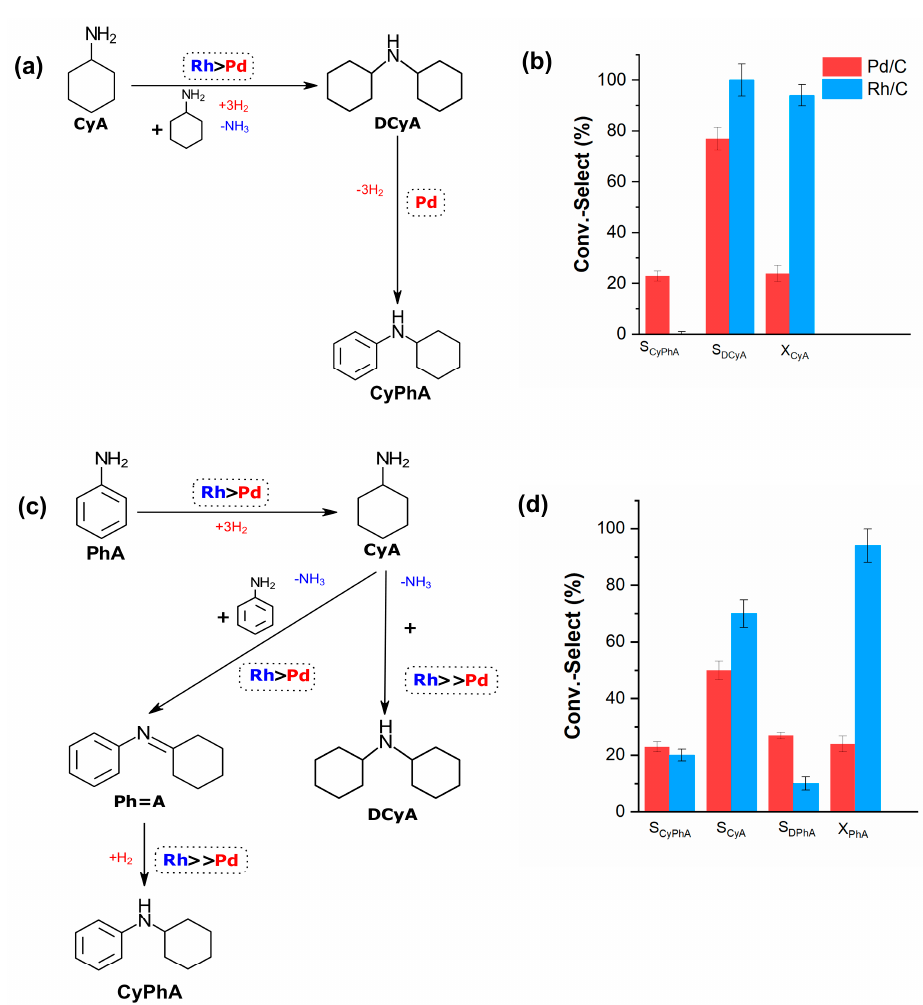
Figure 3. Self-condensation of primary amines ( a ) Cyclohexylamine and ( c ) Aniline on Pd/C and Rh/C with their respective concentration pro fi les and selectivities for ( b ) Cyclohexylamine and ( d ) Aniline. T = 120 °C, P H2 = 1.5 bar, C 0PhOH = 0.2 mol/L, C 0Aniline = 1.4 Eqv., t = 20 h. Mcat = 0.03 g, V R = 4 mL. GC/MS data associated with these experiments is available at ESI_1 and at the mendeley data repository cited at the end of the manuscript.